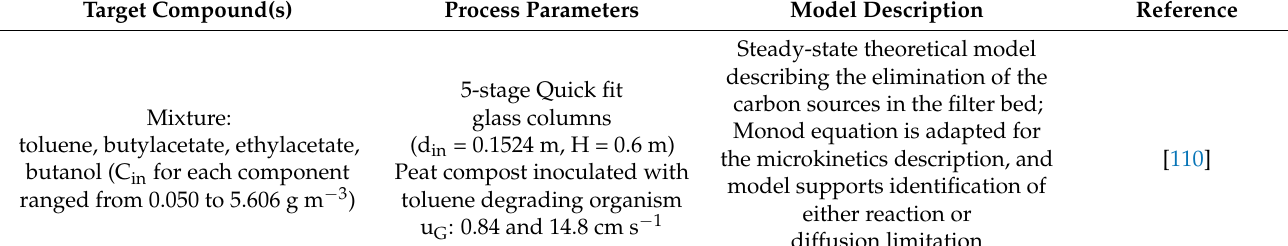
Table 4. Overview of selected mathematical models for conventional